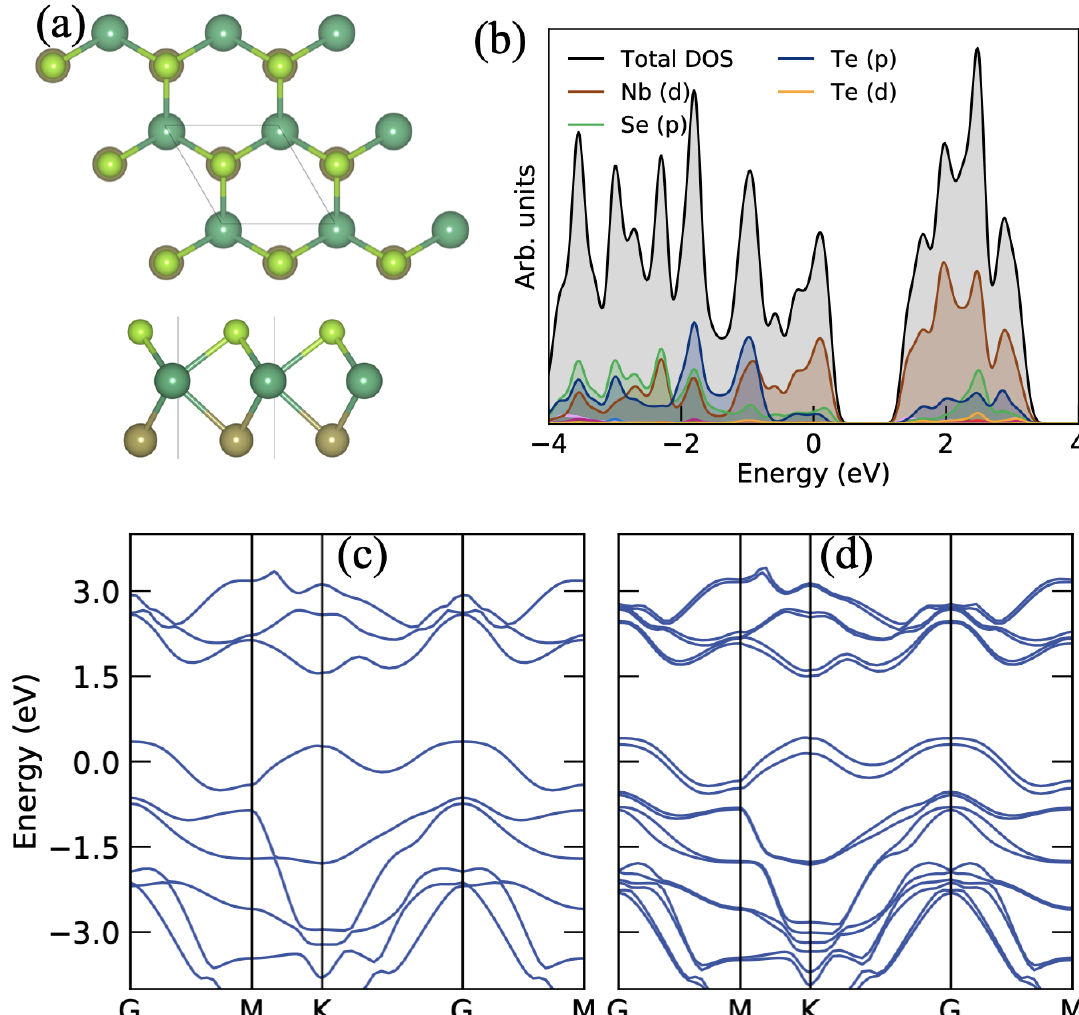
Figure 1. ( a ) Optimized structure with top and side view, ( b ) projected density of states, ( c ) electronic band structure without spin-orbit coupling, and ( d ) electronic band structure with spin-orbit coupling of the Janus NbSeTe